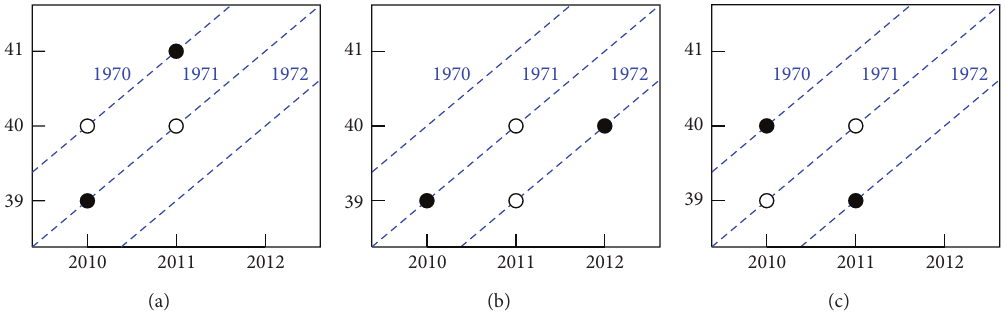
Figure 1: Illustration of interpretation of Δ 2 𝛼 41 , Δ 2 𝛽 2012 , and Δ 2 𝛾 1972